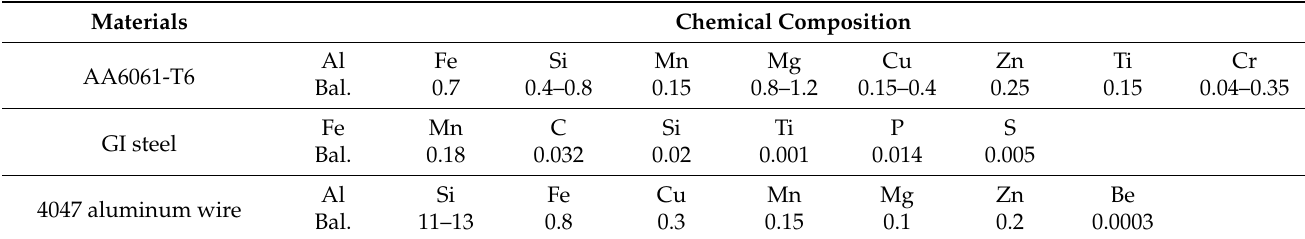
Table 1. Chemical composition of AA6061-T6, GI steel, and 4047 Al-Si alloy filler wire.